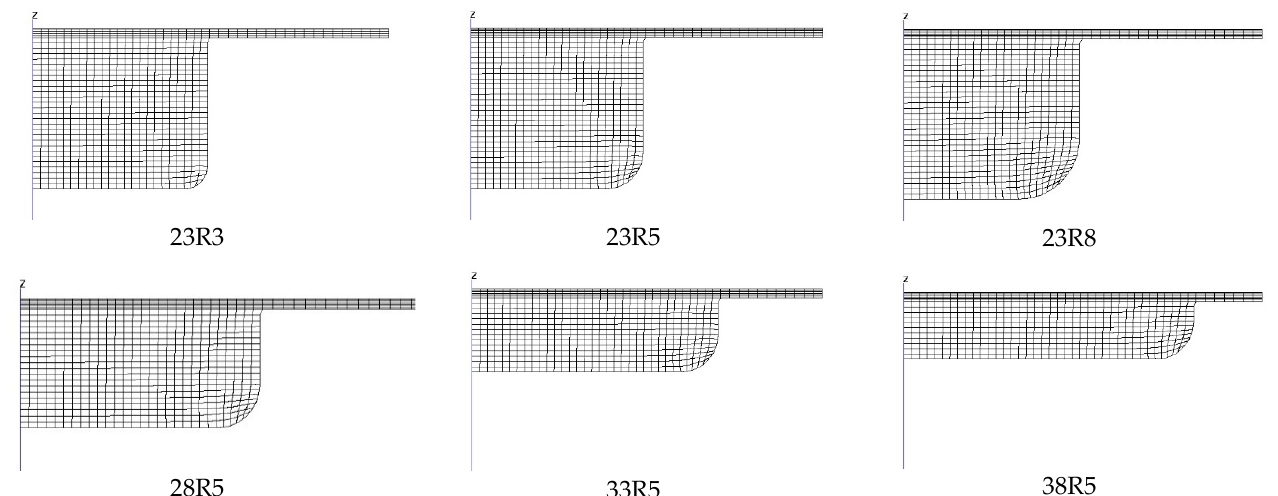
Figure 5. Computational grids of the tested bowls .